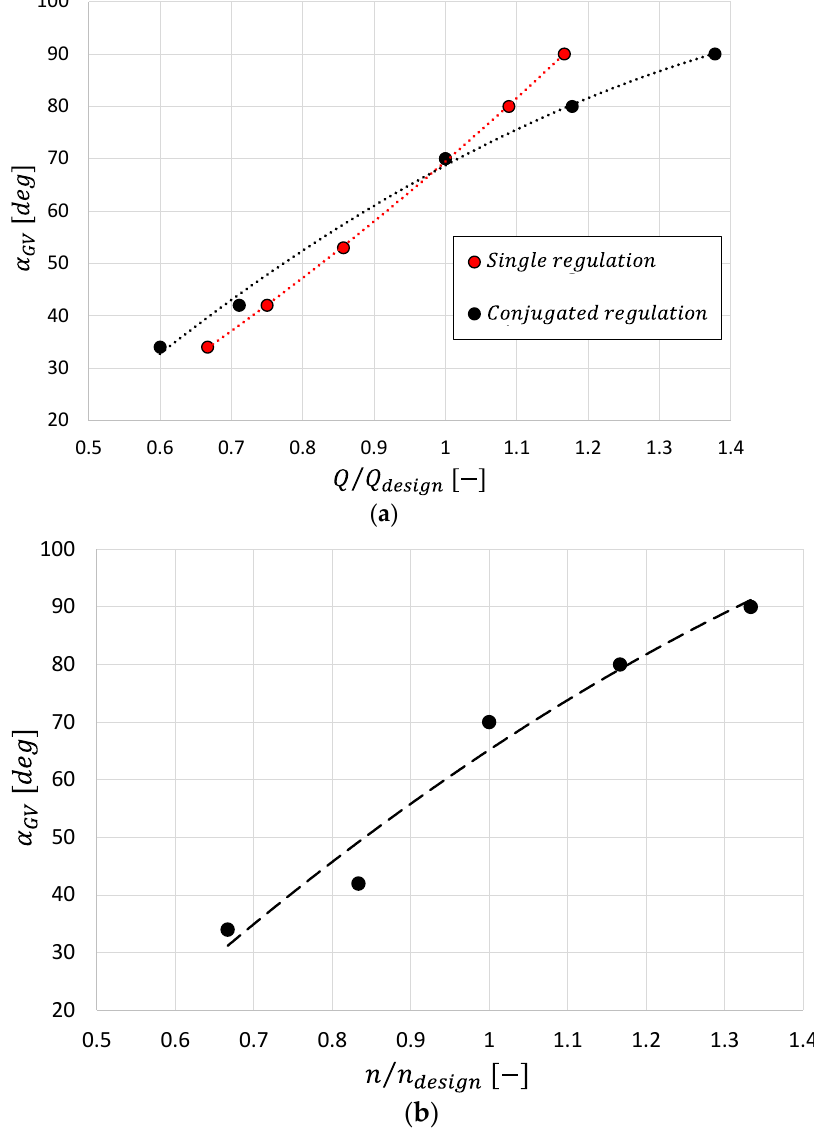
Figure 15. Guide vane opening angle law as a function of Q / Q design ( a ), and the conjugation curve ( b ).